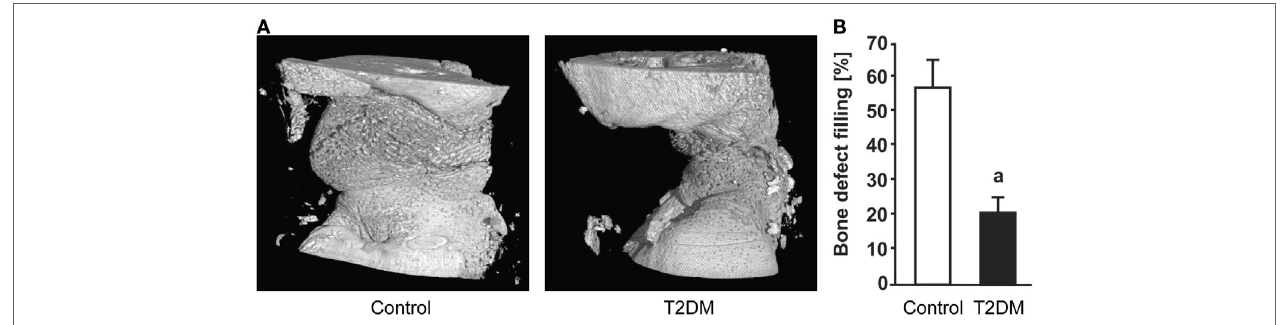
FigURe 2 | (a) 3D representation generated after micro-computed tomography (microCT) scanning of the subcritical femoral defect model in control vs type 2 diabetes mellitus (T2DM) rats, 12 weeks post-surgery. (B) microCT-based quantification of the bone defect filling in control and T2DM femora, 12 weeks post- surgery. n = 7–10. a p < 0.01. Figure taken and adapted from Ref.